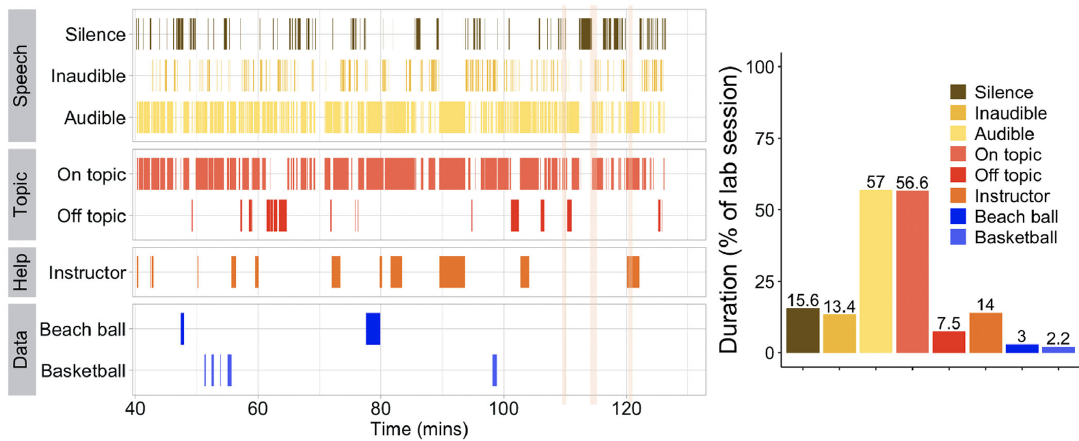
FIG. 16. Group G full timeline and durations of each behavior as a percentage of the video analyzed. The portions analyzed in Sec. V B 3 are